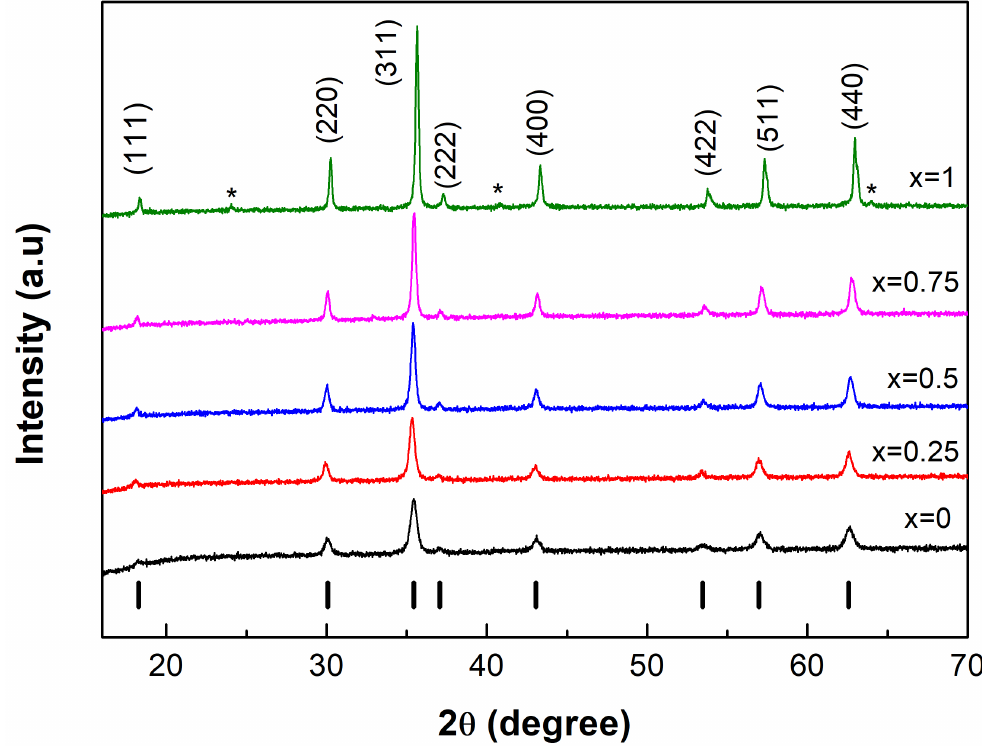
Figure 1. XRD patterns of the Ni x Co 1 − x Fe 2 O 4 spinel ferrites with 0 ≤ x ≤ 1. The black vertical bars represent the standard Bragg reflections of the space group